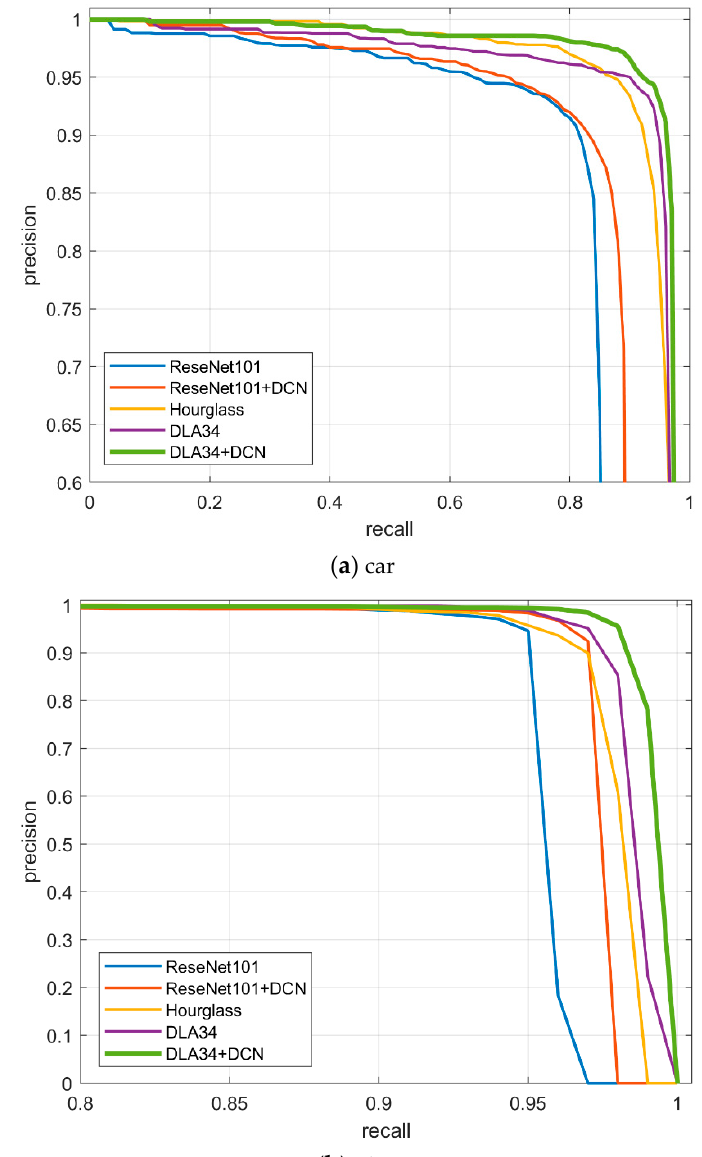
Figure 7. Precision-recall curves of different backbone models used on the UCAS-AOD da-